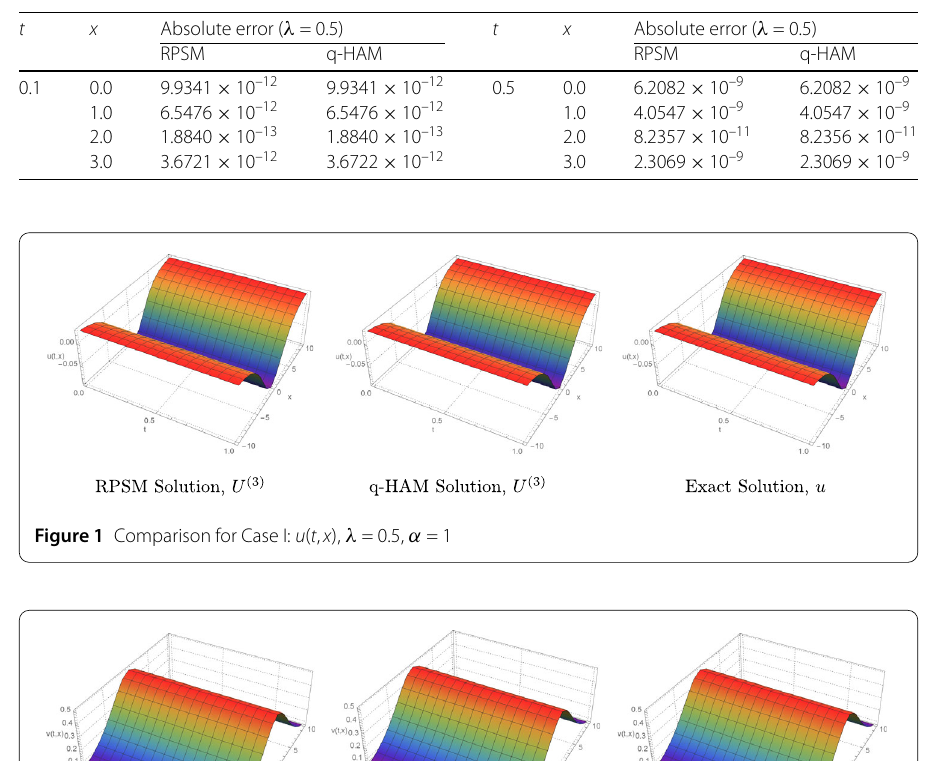
Table 2 Case I Comparison ( V (3) ): RPSM, q-HAM with the exact solution